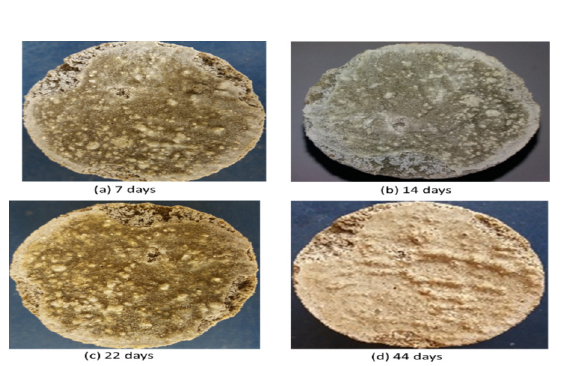
Fig. 10: Comparison of Top of Bacterial + Calcium Lactate Sample